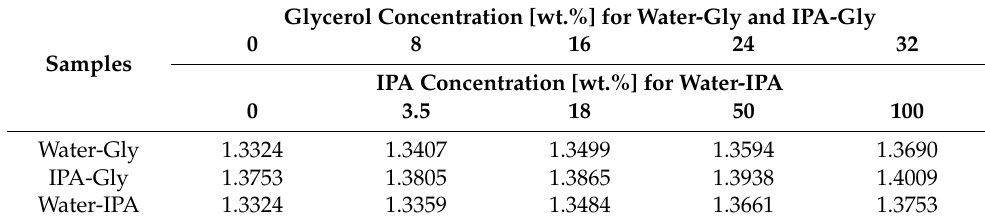
Table 1. Detailed RI values of the sample solutions.